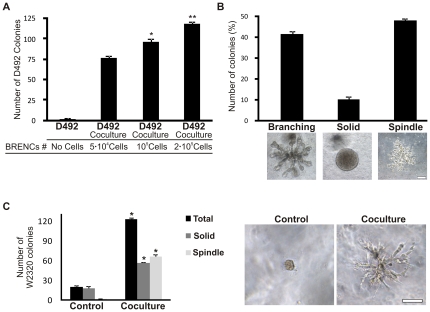
Breast epithelial cells with stem cell properties generate spindle-like cells in coculture with endothelial cells.
A, Colony growth of D492-derived epithelial structures increases proportional with increased number of BRENCs in coculture. When 500 D492 cells are cultured in 300 µl rBM they fail to grow (control). With BRENCs, colony growth increases from 76 (5×104 BRENCs), 96 (1×105 BRENCs) to 117 colonies (23,5% cloning efficacy) when 2×105 BRENCs are inoculated with 500 D492 cells. Average (AVG) number of colonies +SEM in three experiments. *, p<0.05; **, p<0.01; compared to 5×104 BRENCs. B, D492 generate spindle-like cells in coculture with BRENCs (2×105 cells). D492 cells (500 cells incubated) form three distinct structures, branching, solid, and spindle-like colonies. Appearance of the spindle colonies from D492 is novel and occurs only in coculture with endothelial cells. Average % of colony type +SEM in three experiments. Bar 100 µm. C, Using a primary metaplastic breast cancer cell line, W2320, we were able to show that these cells could also produce spindle-like colonies in coculture with BRENCs (right). Data shown as AVG number of colonies +SEM in three experiments (left). *p<0.05. Bar 100 µm.